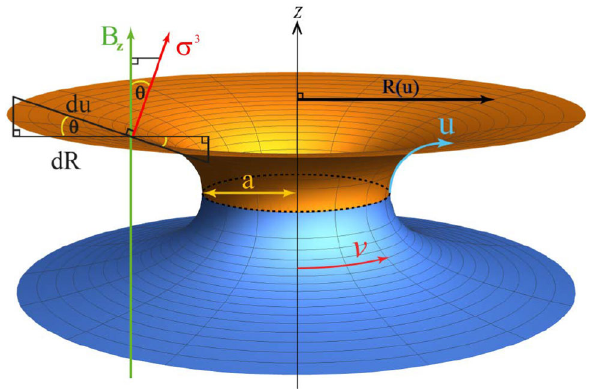
Fig. 1 Geometric structure of a wormhole surface where a is a radius at the radius function R ( u = u 0 = ln q / 2 ) . And r is the radius of curvature of the wormhole surface along u